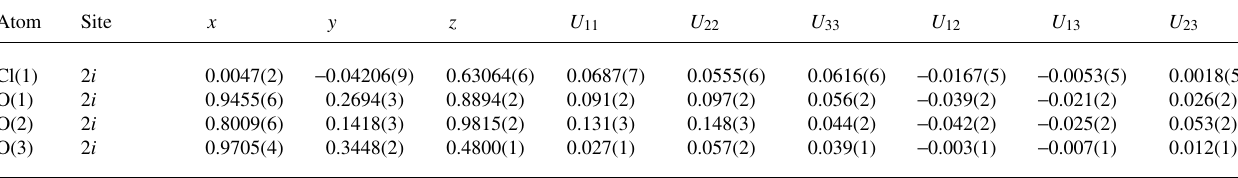
Table 3. Atomic coordinates and displacement parameters (in Å 2 )